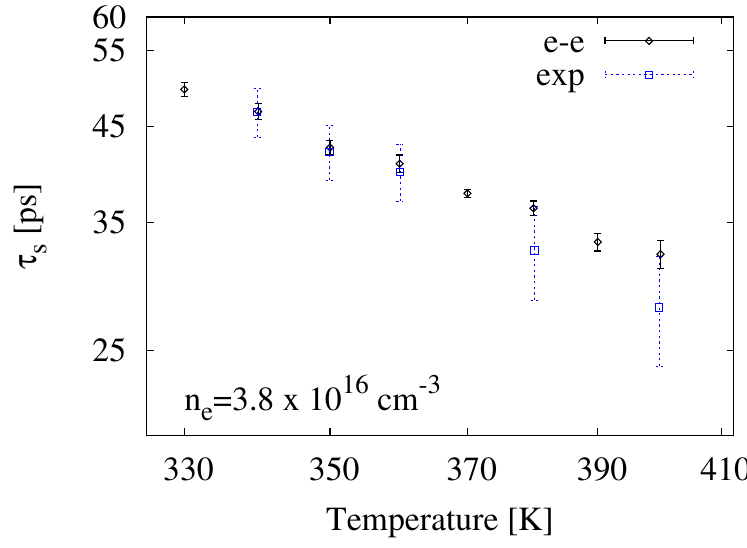
Figure 7. The spin relaxation time, τ , versus temperature for the carrier density s n = 3 . 8 × 10 16 cm − 3 from simulations, including electron-electron interaction, and from the e experimental results, as obtained in [4] (empty square symbols). The simulations are done = 21.9 eV ˚ A 3 and include e-e scattering. Following [4], data are with N = 25 × 10 3 and γ so plotted on a log-log